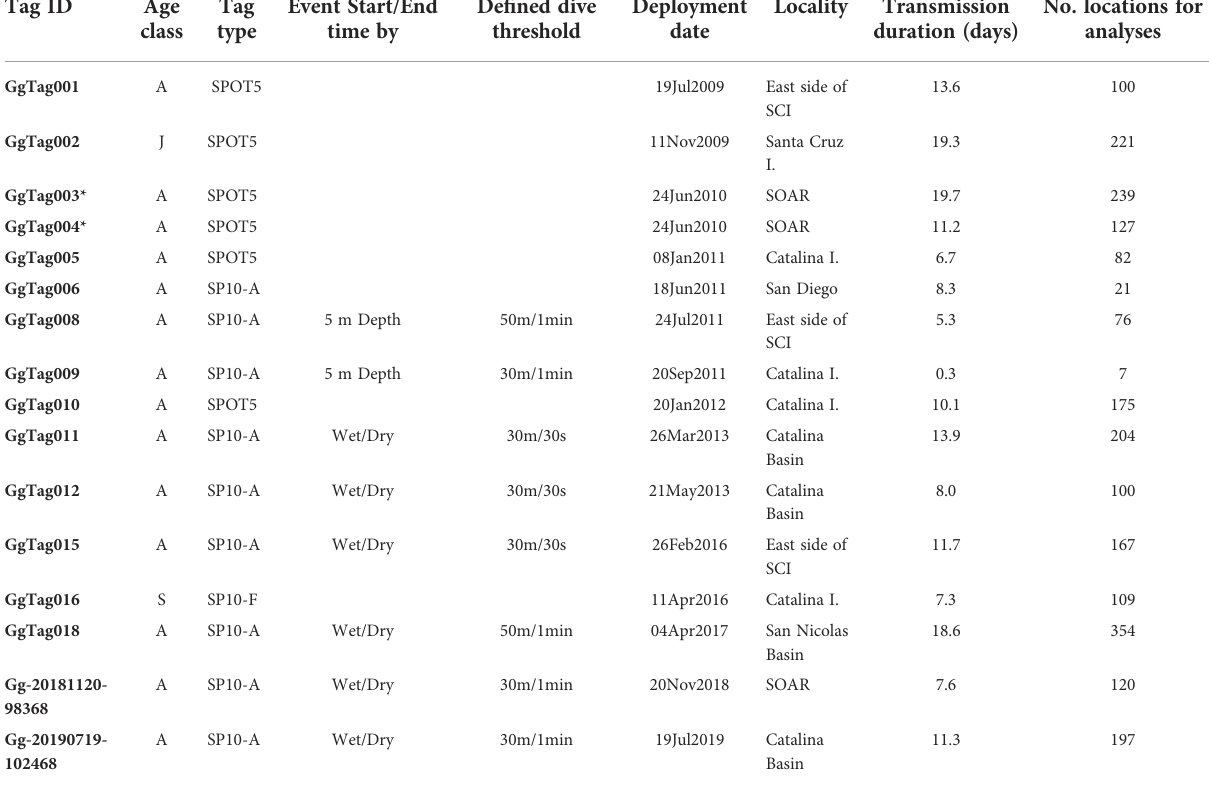
TABLE 1 Details of Risso ’ s dolphin satellite tag deployments by individual. Tag